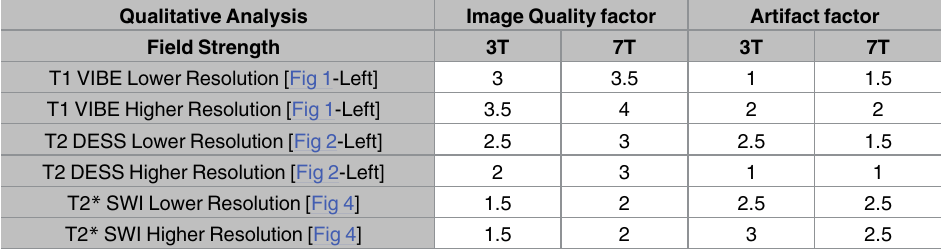
Table 3. 3T/7T MRI Analysis [Image Quality Scale: 1-nondiagnostic, 2- poor, 3-fair, 4-good and 5-excellent; Artifactsscale: 1-absent, 2-present but not affecting anatomic detail and 3-present and severelyaffecting image interpretation].